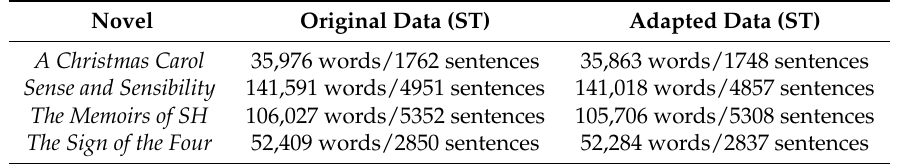
Table 2. Overview of data for key feature analysis: Number of words and sentences in each novel before and after data was